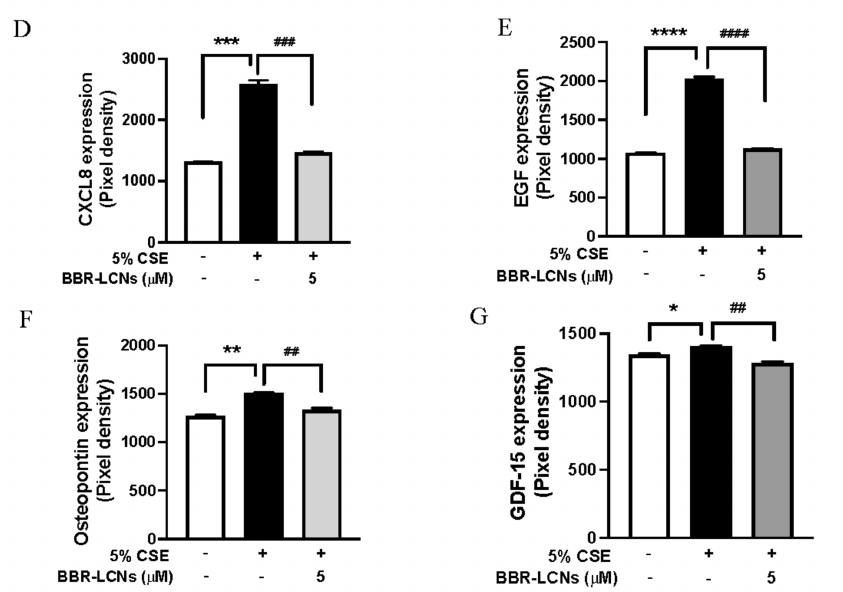
Figure 5. Expression of cytokines in human cytokine protein array. ( A ) protein blot, ( B ) uPAR, ( C ) GM-CSF ( D ) CXCL8, ( E ) EGF, ( F ) Osteopontin, and ( G ) GDF-15 upon treatment with BBR-LCNs on 16HBE cells. Values are expressed as mean ± SEM (n = 2–4); * p < 0.05, ** p < 0.01, *** p < 0.001, **** p < 0.0001 (control vs. 5% CSE) and # p < 0.05, ## p < 0.01, ### p < 0.001, #### p < 0.0001 (5% CSE vs. 5% CSE + BBR-monoolein). Analysis was performed by a one-way ANOVA followed by Tukey multiple comparison test.